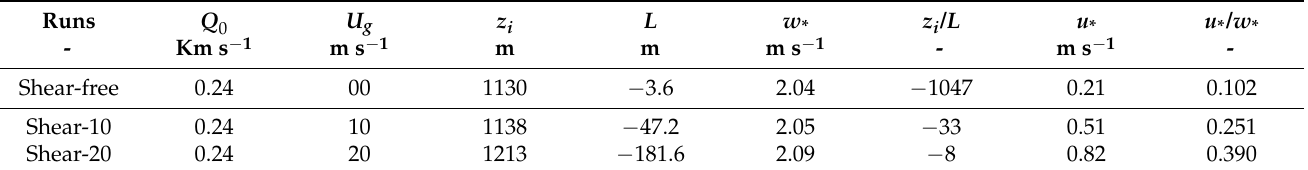
Table 1. Properties of numerical simulations, including geostrophic velocity ( U g ), surface heat flux ( Q 0